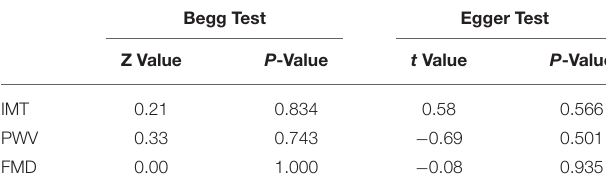
( Table 1 ). The Begg test ( P = 0.743) and Egger test ( P = 0.501) was no obvious publication bias ( Table 2 ). There was no significant change in the SMD (95%CI) by taking out studies one by one ( Supplementary Materials Supplementary Table S7 ). ( Supplementary Materials Supplementary Table S8 ) failed to explain the cause of